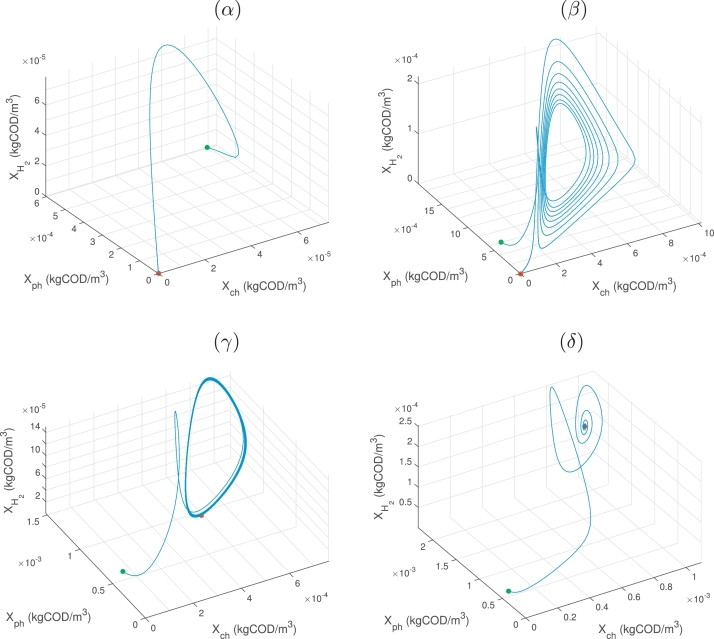
Three-dimensional phase plane diagrams of the biomass dynamics for t=10000d, showing initial (green dot) and final (red dot) conditions for a dilution rate, D=0.01d−1 and chlorophenol input, Sch, in (kgCOD/m3), of (α): Sch,in=0.01 - the system converges to SS1, (β): Sch,in=0.097 - the system enters a periodic orbit of increasing amplitude, ultimately converging to SS1, (γ): Sch,in=0.10052 - the system is close to a stable limit cycle, (δ): Sch,in=0.16 - the system undergoes damped oscillations and converges to SS3. (For interpretation of the references to colour in this figure legend, the reader is referred to the web version of this article.)